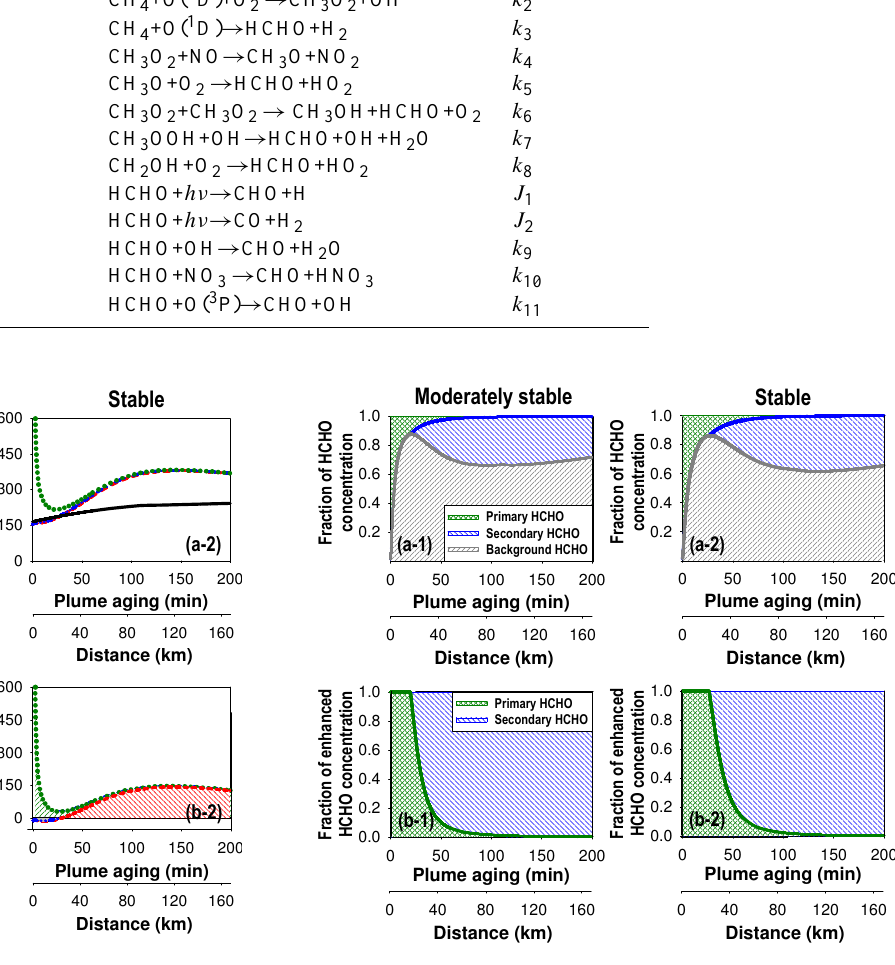
Fig. 3. Cross-section averaged HCHO mixing ratios from three case simulations (CASEs I, II, and III) and Background HCHO mixing ratios: (a) changes in the cross-section averaged ship-plume HCHO mixing ratios; (b) differences between the cross-section averaged ship-plume HCHO mixing ratios and the model-simulated back- ground HCHO mixing ratios. The first and second columns show the results from the model-simulations under the moderately stable (E) and stable (F) MBL conditions, respectively.